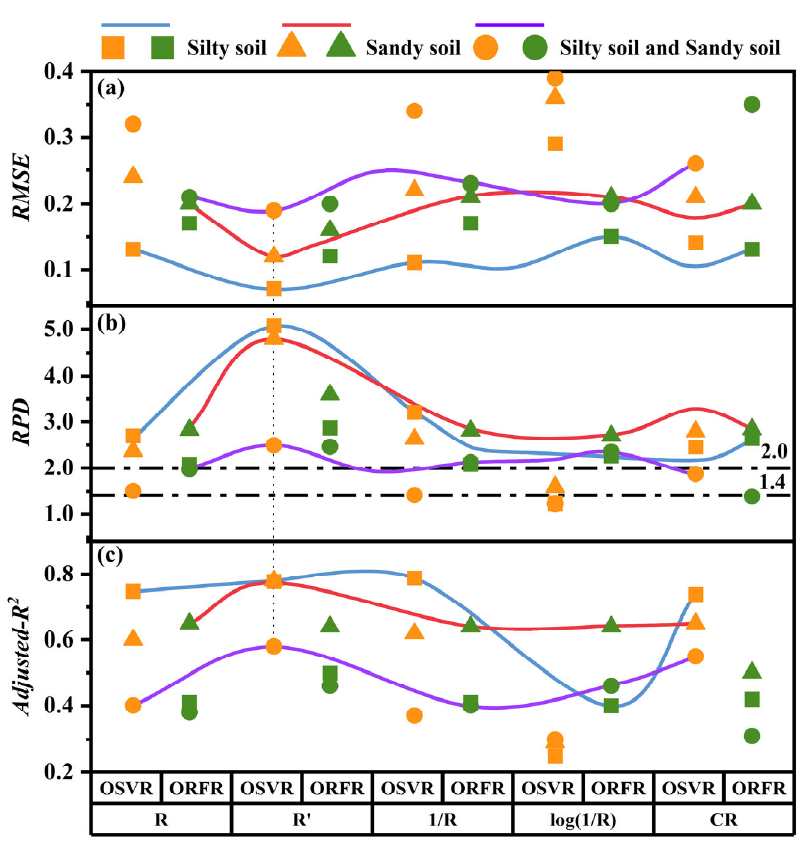
Figure 10. Model evaluation comparison. ( a ) RMSE ; ( b ) RPD ; ( c ) Adjusted ‐ R 2 .